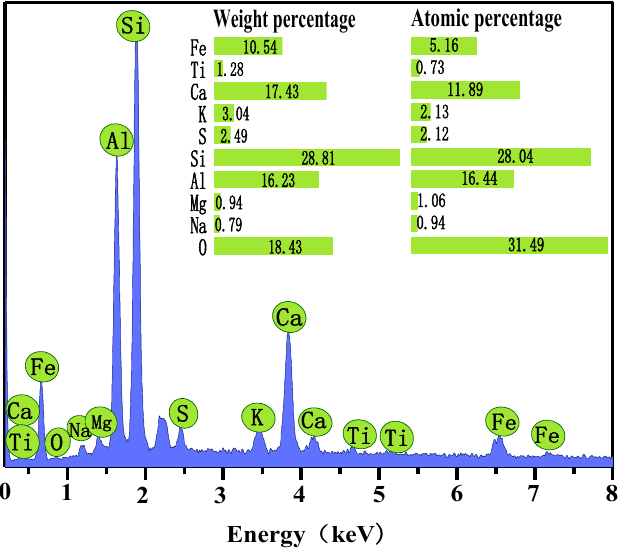
Figure 10. EDX general spectrum of MS7 modified dredged sludge sample.